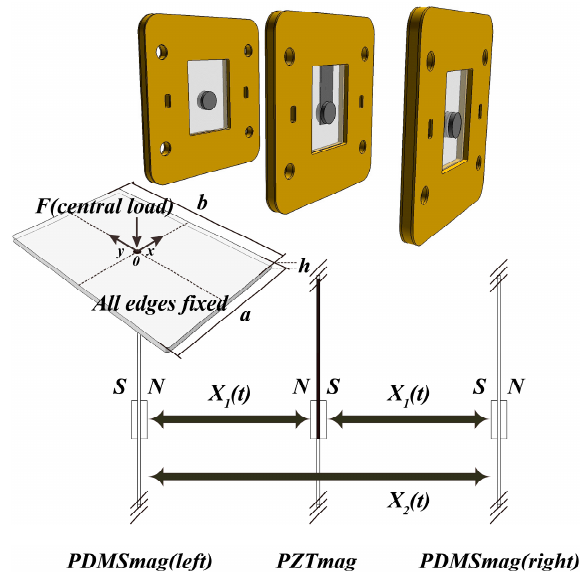
Figure 3. Parameters of PZTmag and PDMSmag.